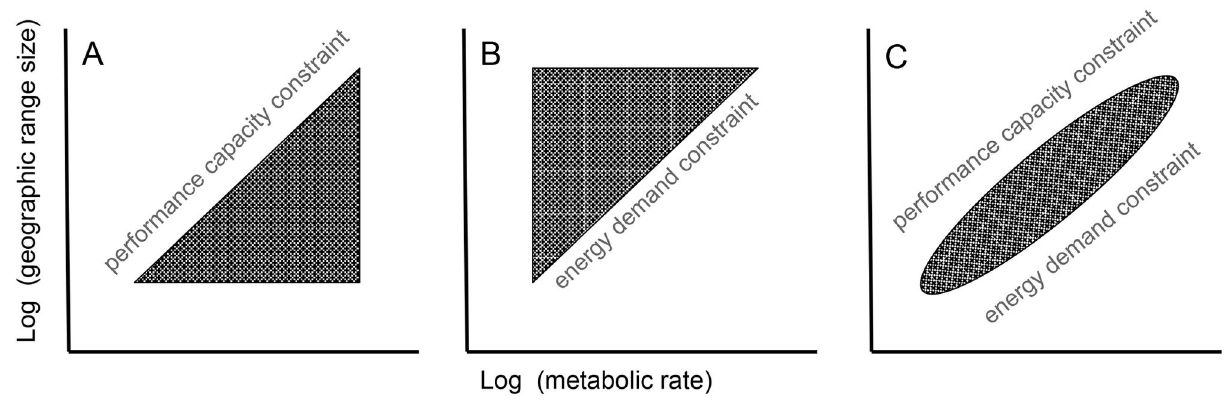
Figure 1. Hypothetical forms of a positive macroecological relationship between basal metabolic rate (BMR) and geographic range size. (a) Expected relationship if low BMR (low performance capacity) is a constraint on achieving large range size (upper bound with positive slope) and high BMR is an advantage for achieving large range size, but not a constraint on persisting with small range size (constant lower bound). This pattern would be consistent with the Thermal Plasticity Hypothesis and Activity Levels/Dispersal Hypothesis. (b) Expected relationship if high BMR (high energy demand) is a constraint on persisting with large range size (lower bound with positive slope), but not a requirement for achieving large range size (constant upper bound). This pattern would be consistent with the Energy Constraint Hypothesis, and is the same pattern described previously for the relationship between body size and range size. (c) Expected relationship if constraints on range size operate at both ends of the BMR spectrum. At low BMR, species are constrained against achieving large ranges as in (a). At high BMR, species are constrained to have large ranges as in (b). See text for